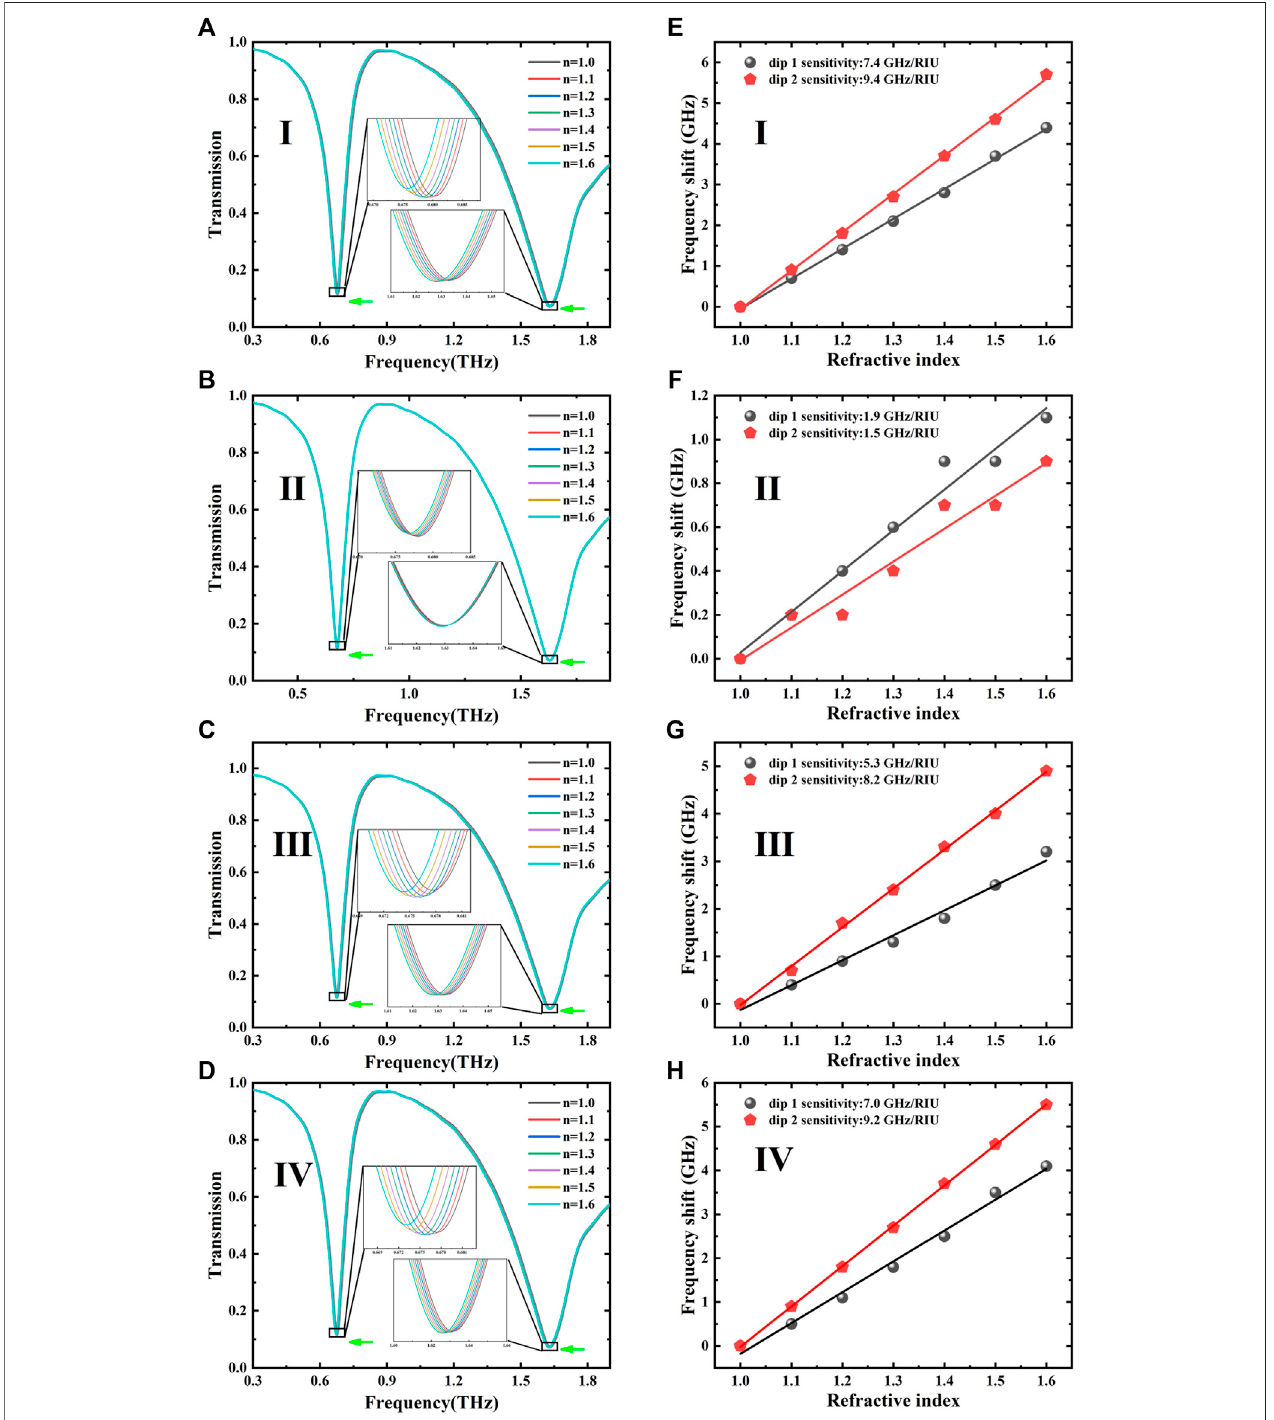
FIGURE 5 | (A – D) Transmission spectra of MM sensors for four cases under various refractive indices. (E – H) Corresponding relationship between the frequency shift and the refractive index.